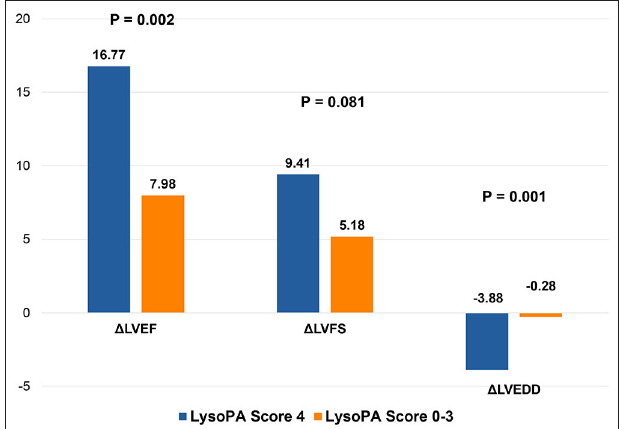
FIGURE 3 | Changes in left ventricular structure and function in different LysoPA score group during 1 year. LVEF, left ventricular ejection fraction; LVFS, left ventricular fraction shortening; LVEDD, left ventricular end-diastolic